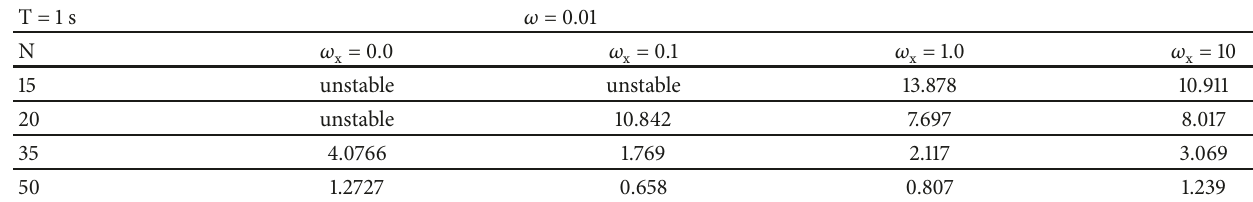
Table 2: IAE quality measure for system